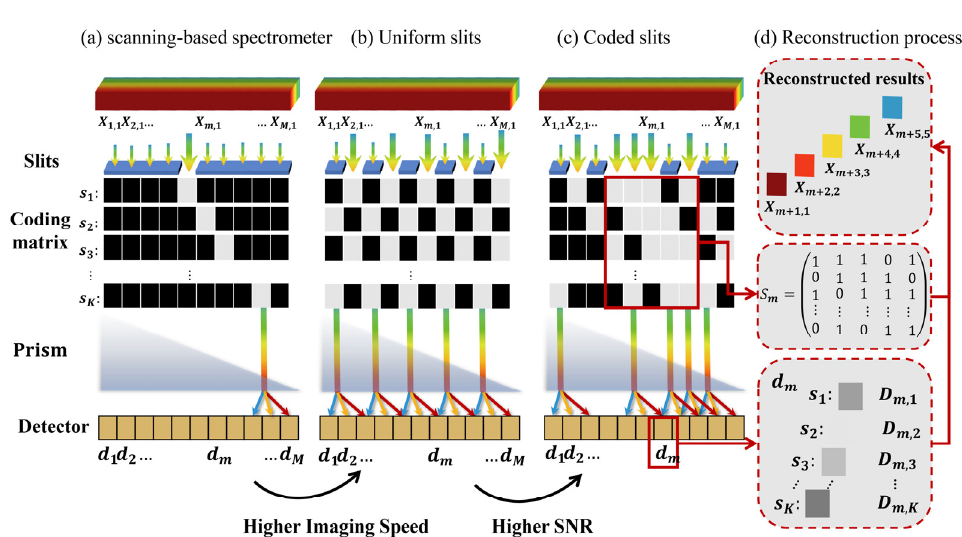
Figure 1. System schematic for the RHVS video acquisition.